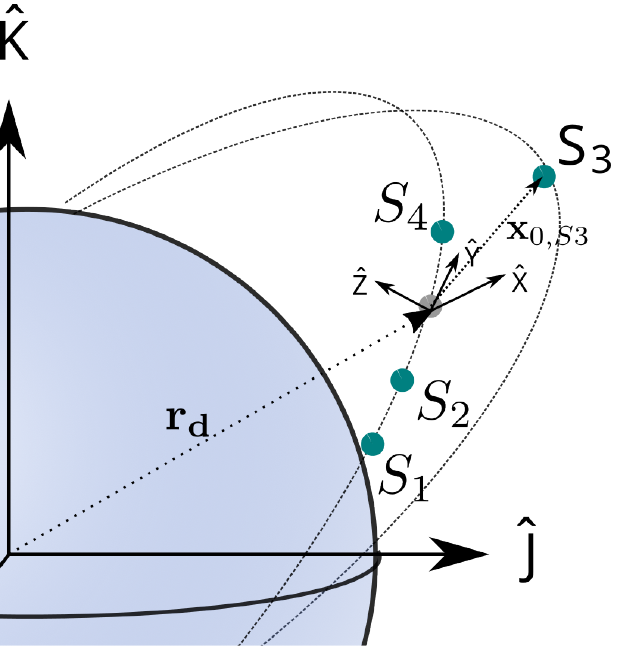
Figure 14. Initial state of all four satellites with the moving Hill coordinate frame centered at the desired position of satellite 3 in the formation.